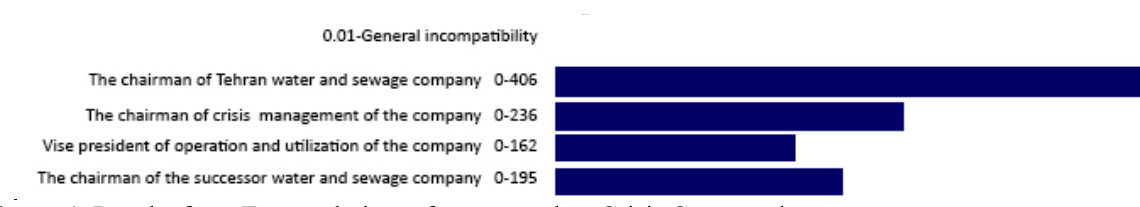
ggfff Figure 1. Results from Expert choice software to select Crisis